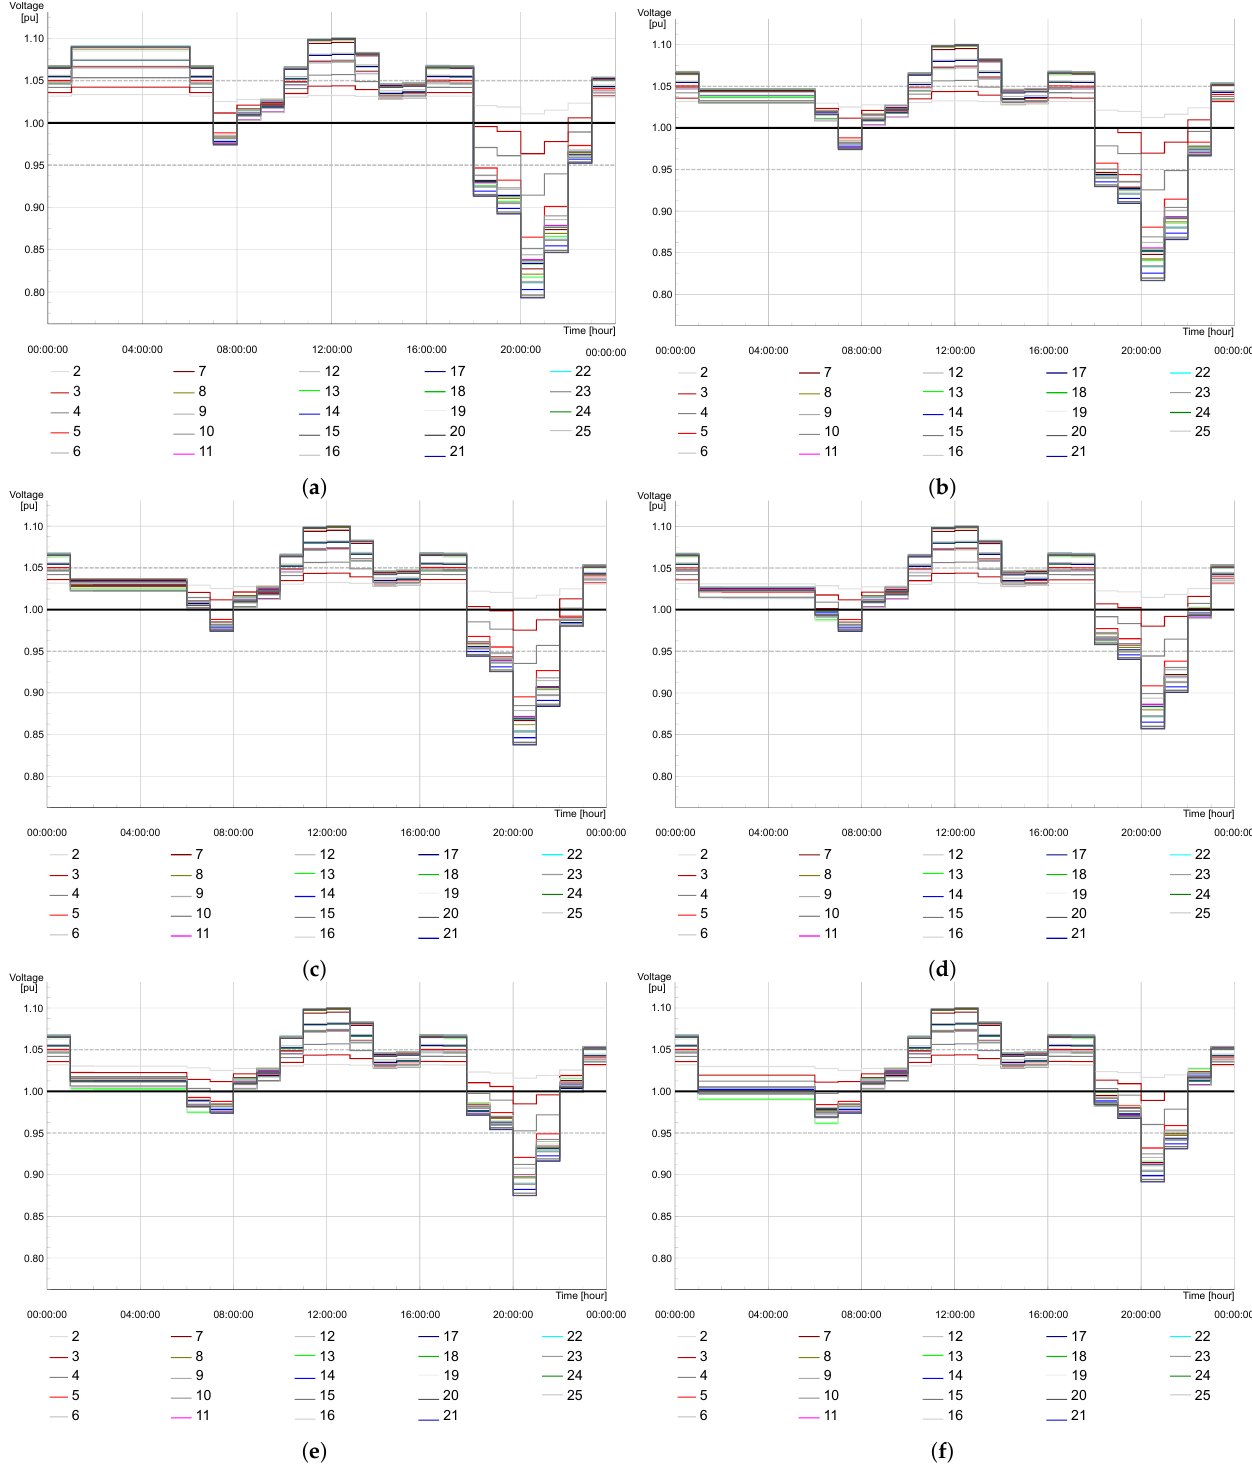
Figure 4. Voltage profiles obtained in the HEDNO distribution network simulation (each color represents the node voltage of the electrical system): ( a ) Baseline scenario, ( b ) 10% of EVs with V2G , ( c ) 20% of EVs with V2G , ( d ) 30% of EVs with V2G , ( e ) 40% of EVs with V2G , ( f ) 50% of EVs with V2G